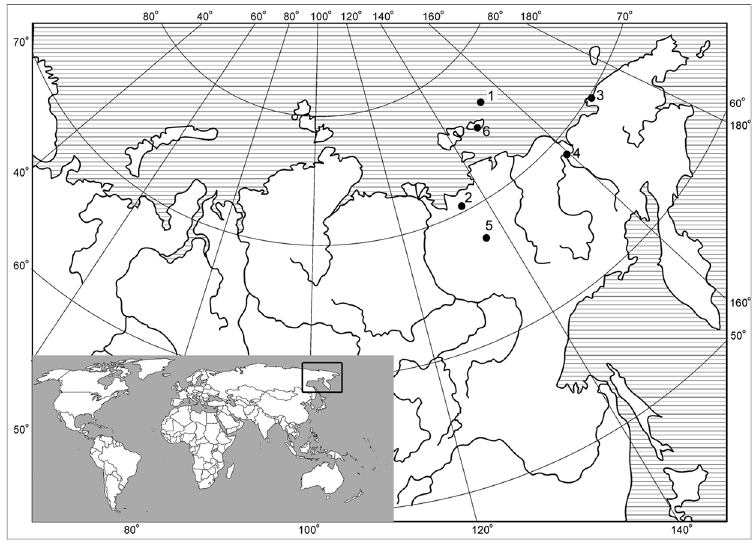
Fig 1. Location of the sites studied. Corresponding numbers and information are provided in Table